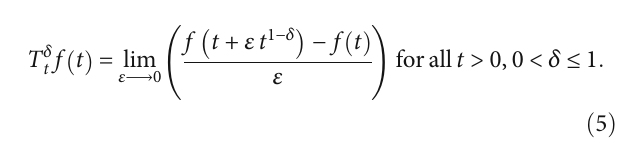
Figure 3: Dynamical behavior of function solution of u